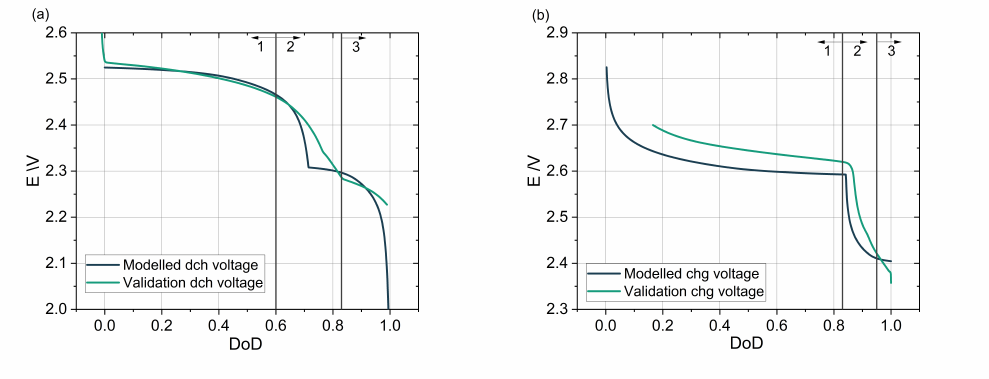
Figure 4. Model validation with 1/8C ( I = 5.125 A ): ( a ) discharge (dch) and ( b ) charge (chg). Highlighted are three different segments: 1 and can be removed. The following highlights are the same. refers to the voltage plateau according to Equation (1); 2 refers to the transition towards the next plateau; and 3 is related to the voltage plateau according to Equation (2).